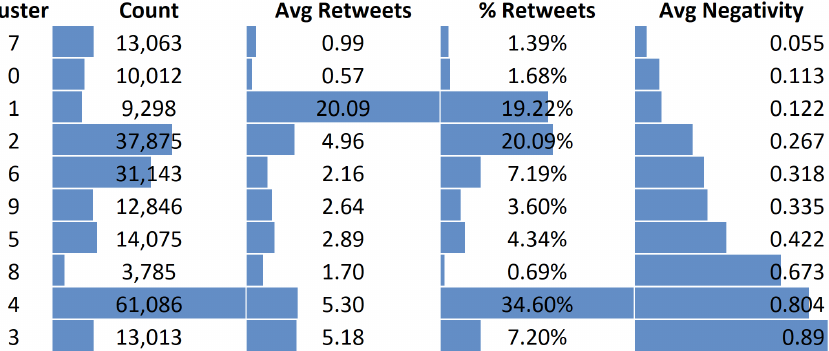
Figure 5. Number of tweets (count), average retweet count, retweet count percentage, and average sentiment (negativity) by cluster. Ordered by the average sentiment where the negative class is 1, and the neutral and positive are